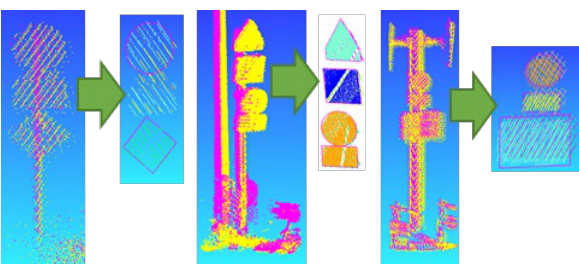
Figure 11. Example of obtaining detailed position of road signs